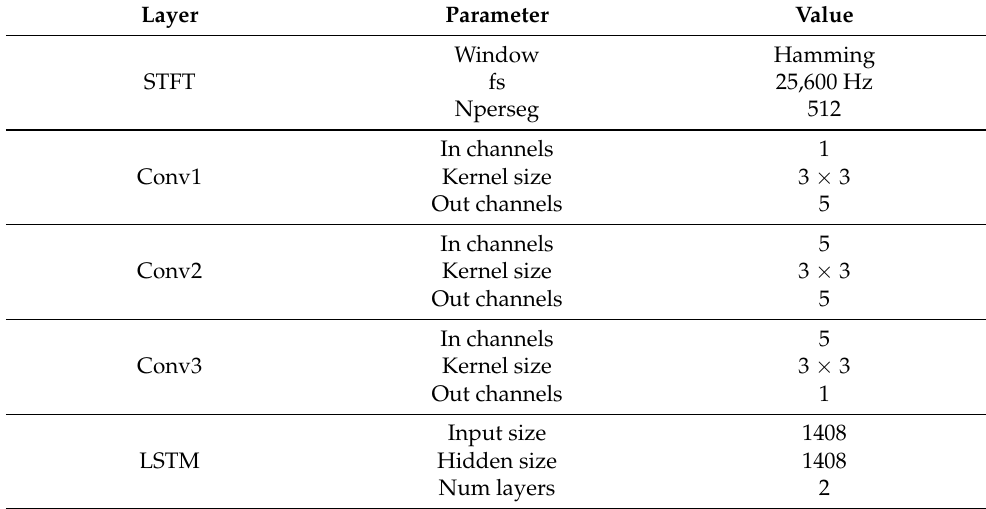
Table 1. Architecture of SAL-CNN.